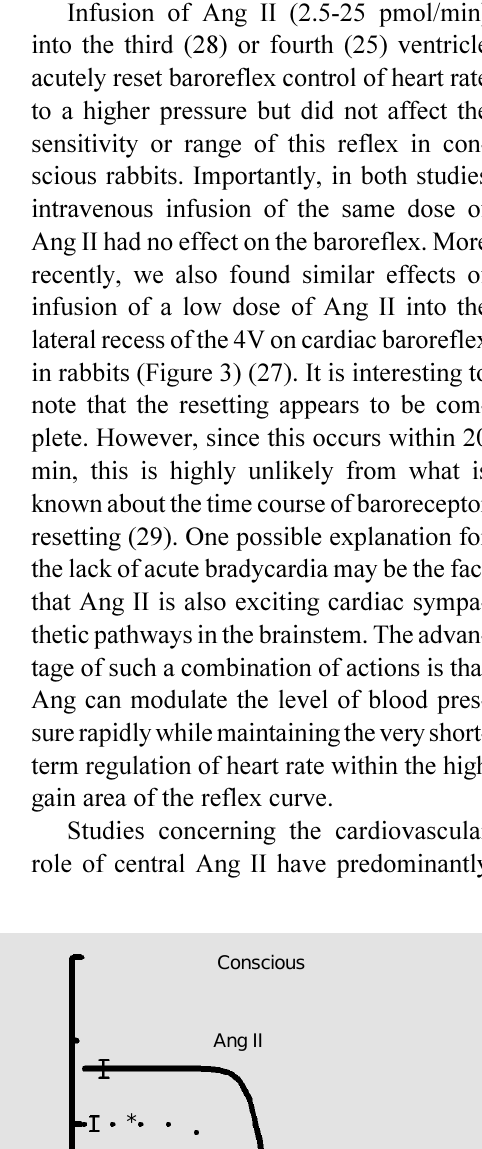
Figure 2. Average mean arterial pressure (MAP) and renal sym- pathetic nerve activity (RSNA) baroreflex curves before (con- trol, dotted lines) and during in- fusion of Ang II into the fourth ventricle (solid line) from 6 ure- thane-anesthetized rabbits (left panel) and 5 conscious rabbits (right panel). Circles on curves are basal values. nu = normal- ized units. *P<0.05 for differ- ence between upper plateaus. Adapted with permission from Refs.